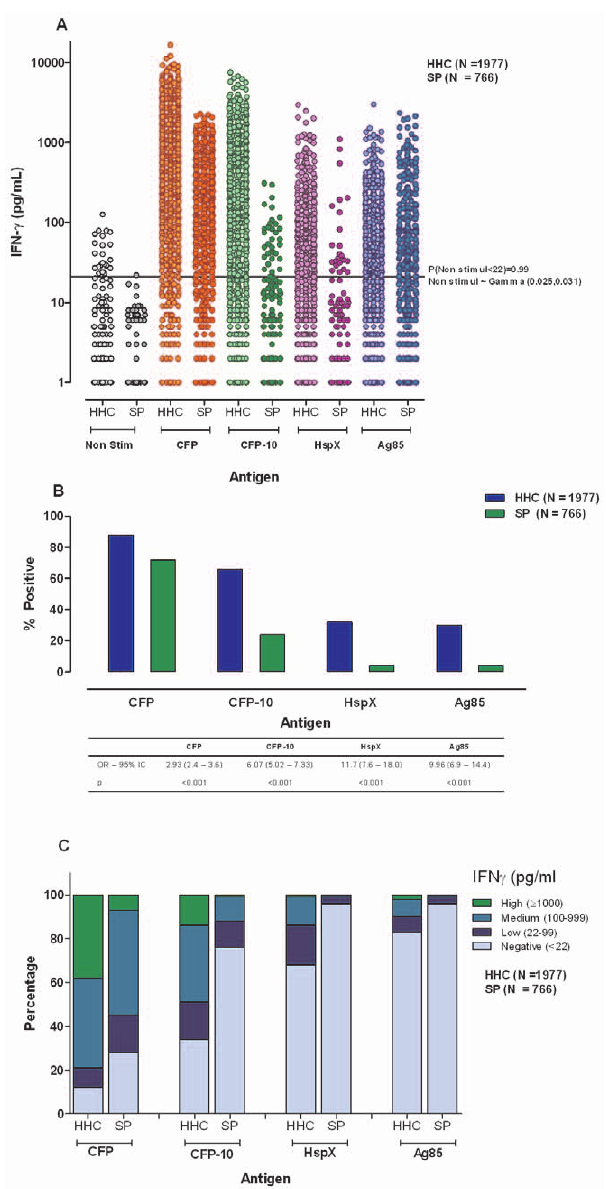
Figure 2. IFN c production by HHCs and SP. IFN c production in whole blood cultures stimulated with four mycobacterial antigens in household contacts and source population. A. IFN c levels produced in non stimulated and CFP, CFP-10, HspX and Ag85A, stimulated cultures. B. Bar graphs depicting the percentage of positive responders and OR in HHCs and SP. C. Stacked bars represent a modification of the IFN c production levels proposed by Andersen et al [11] showing: Negative: , 22pg/mL, Low: 22–99 pg/mL Medium: 100–999 pg/mL, High: $ 1000 pg/mL. HHCs: Household Contacts; SP: Source Population.